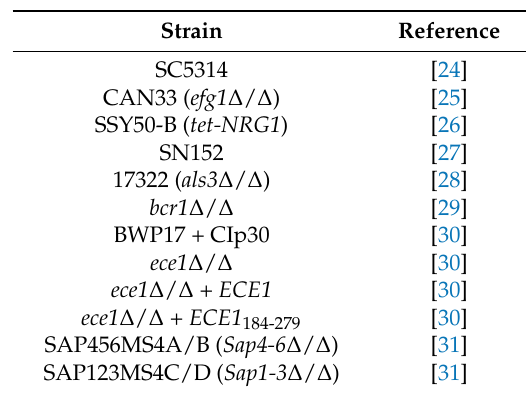
Table 1. List of